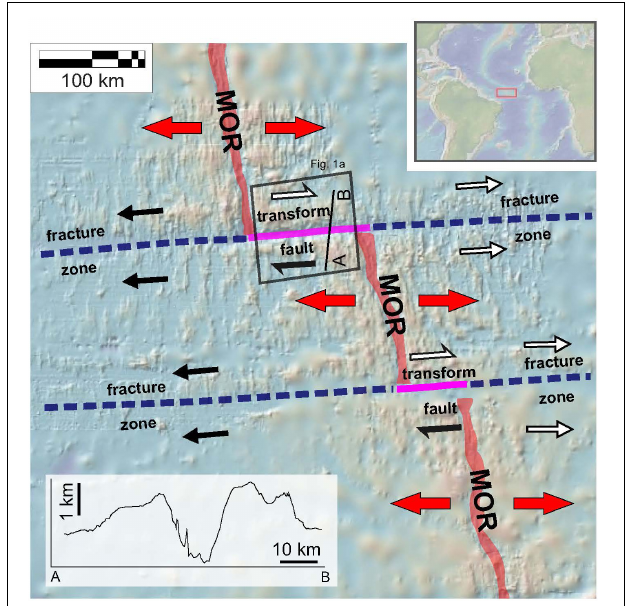
FIGURE 1 | Bathymetric map of the Central Atlantic showing main morphological features of typical ridge-ridge transform fault sections (RRTF; bathymetric data were from GeoMapApp; Ryan et al.,